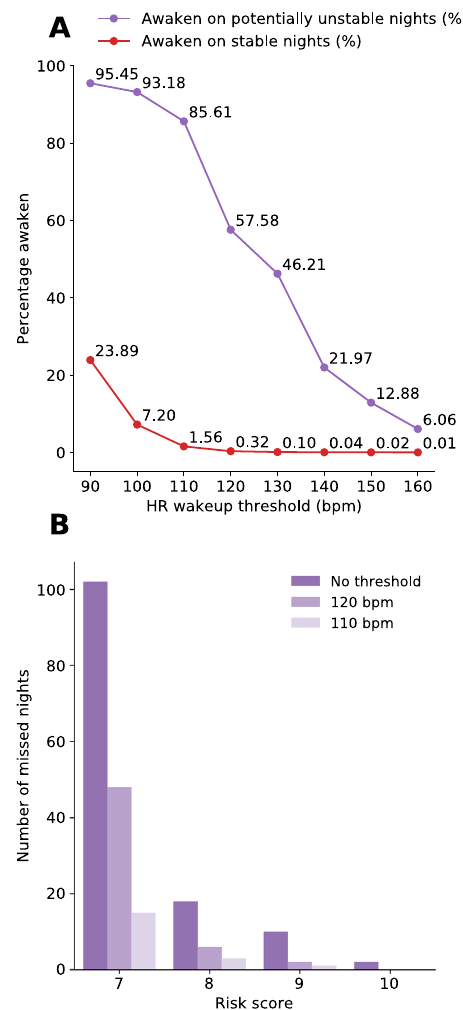
Fig. 6 Detection of the instability of misclassi fi ed patients by overnight heart rate thresholds. Using only continuous heart rate monitors, and setting simple thresholds for alerting could facilitate patient recovery of erroneously classi fi ed patients who are potentially unstable. At various waking thresholds, most potentially unstable patients will be woken while some stable patients will also be woken (e.g., at the level of 100 b.p.m., 93.2% of potentially unstable patients and 7.2% of stable patients are additionally woken for assessment) ( a ). In the test set, 132 patients were misclassi fi ed as stable despite having a potentially unstable night. Using a threshold of 110 or 120 b.p.m., 113 (86%) and 76 (58%) potentially unstable sleepers, respectively, are identi fi ed, and the highest risk (risk